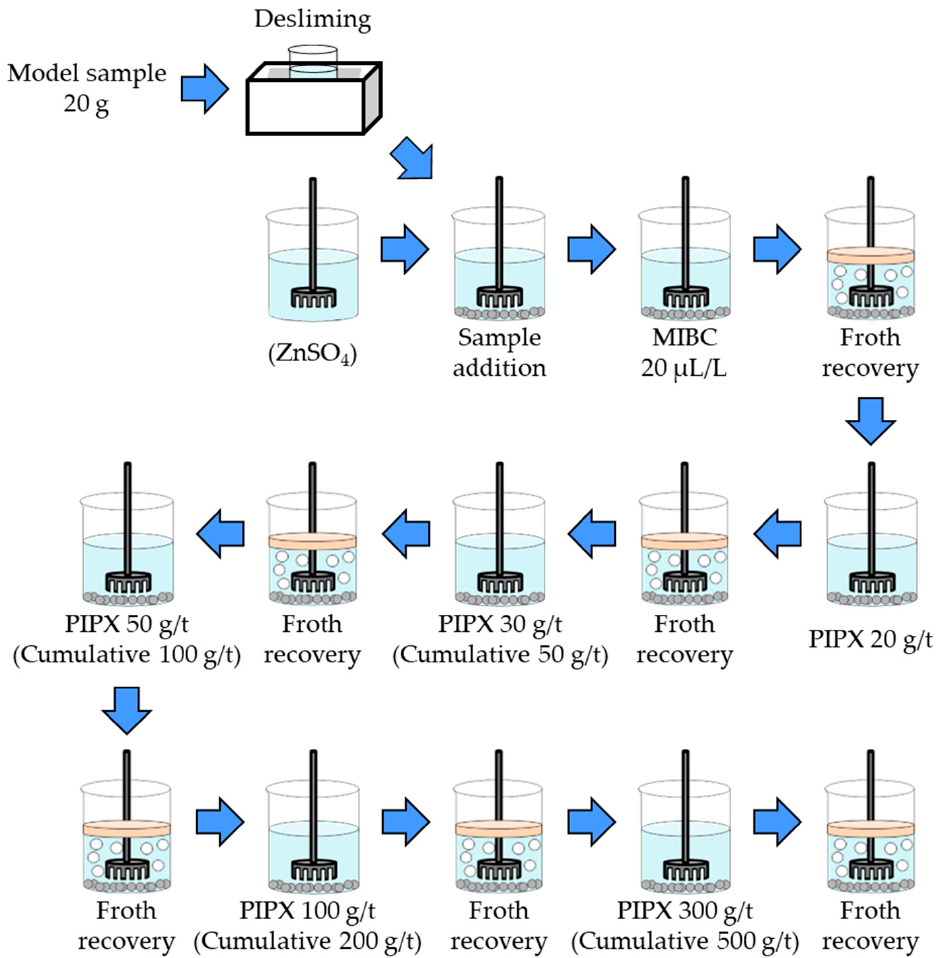
Figure 2. Flotation procedure with sequential addition of the collector